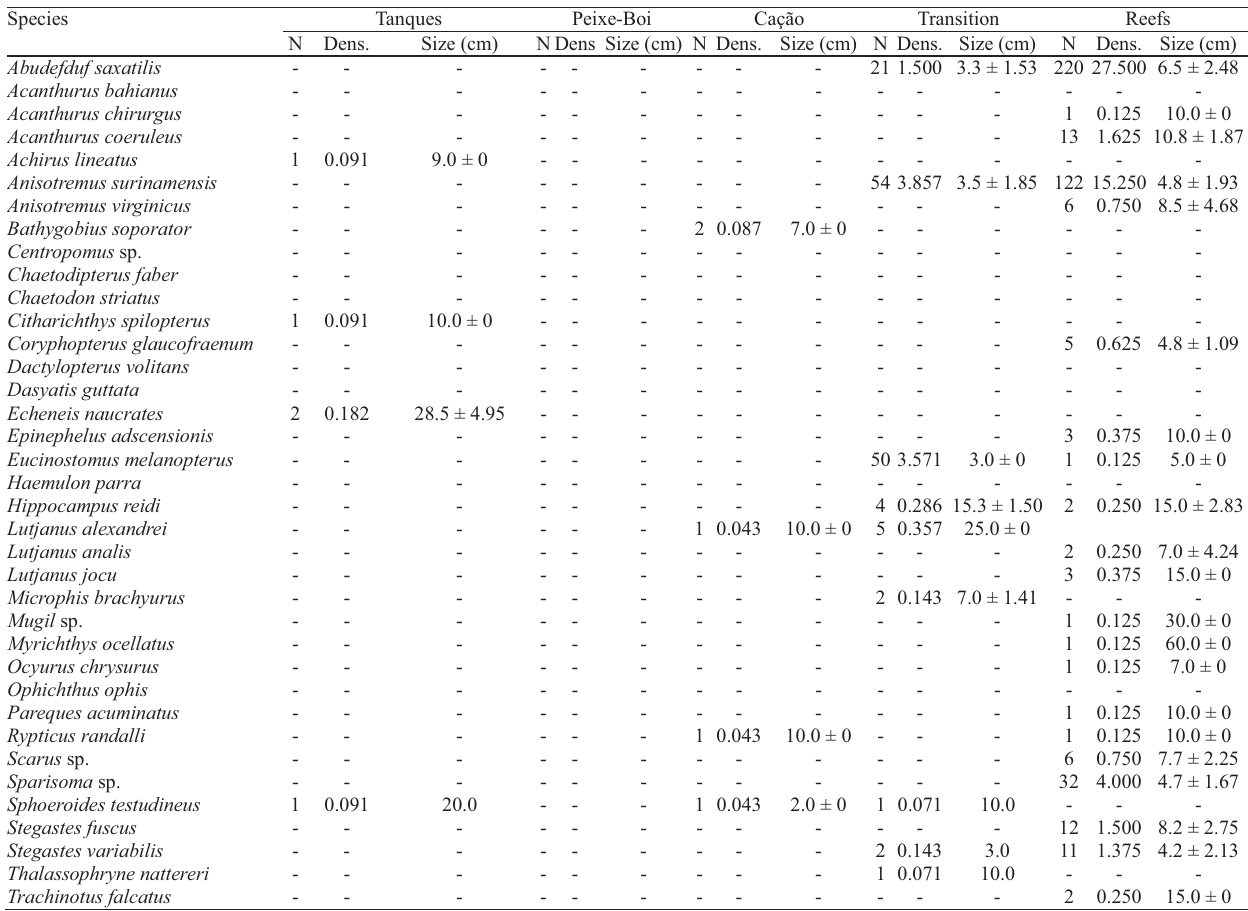
Table 4. Species abundance (N), population density (Dens.) as individuals per 100 m 2 and size (mean + standard deviation) of fishes sighted at the Mamanguape Mangrove-Reef System, State of Paraíba, NE Brazil, according to each sub-area during the rainy season (March to August